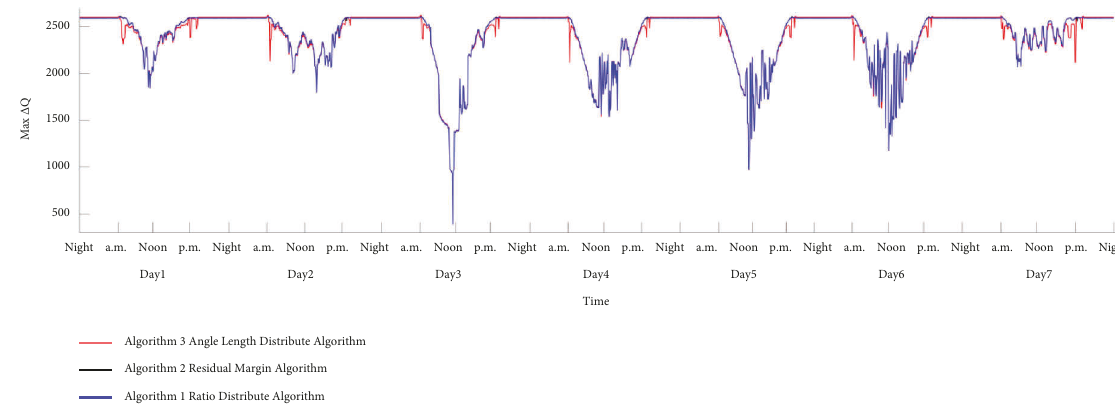
Figure 9: Maximum Δ Q comparison of three algorithms.